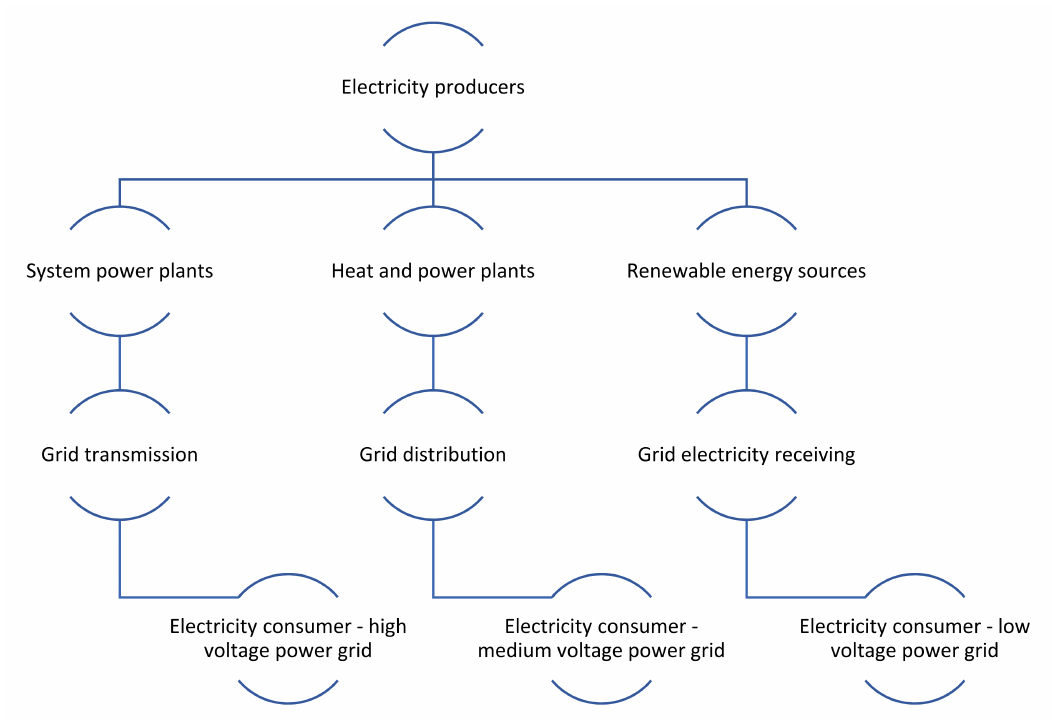
Figure 1. The energy sector in